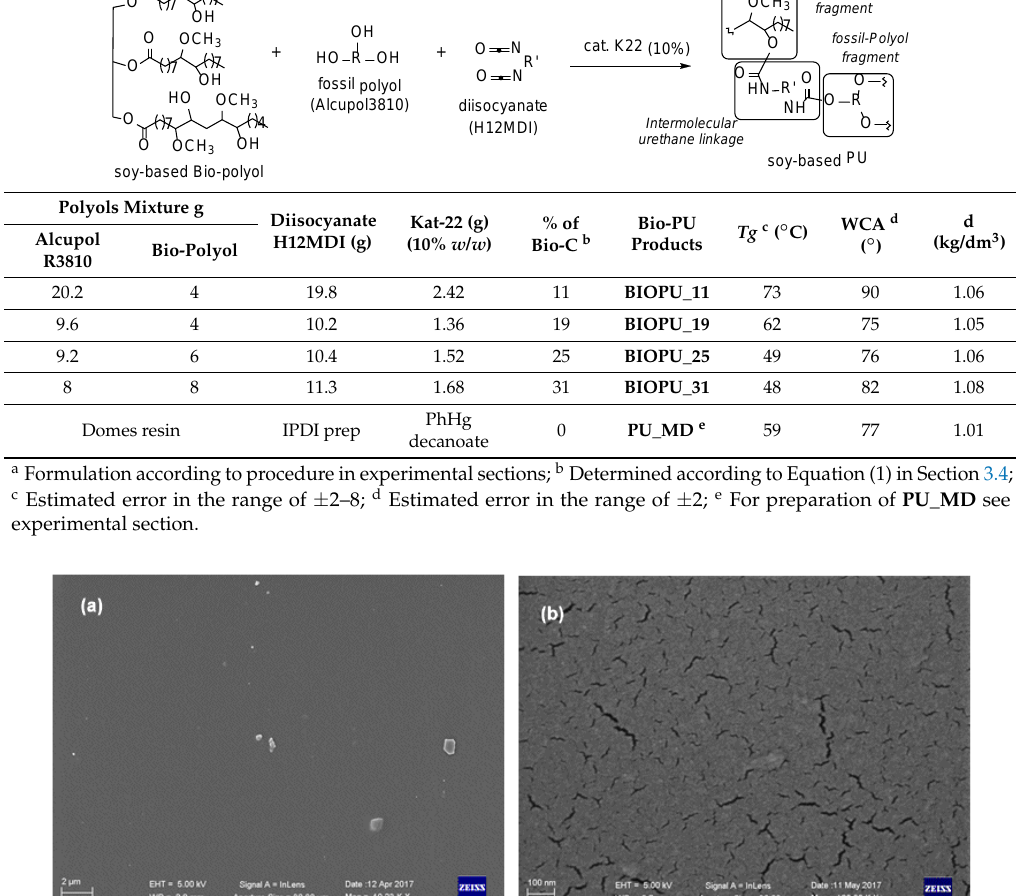
Table 3. Formulation of soy-based BIOPU_%C from PU_3810/K22/H12MDI a .